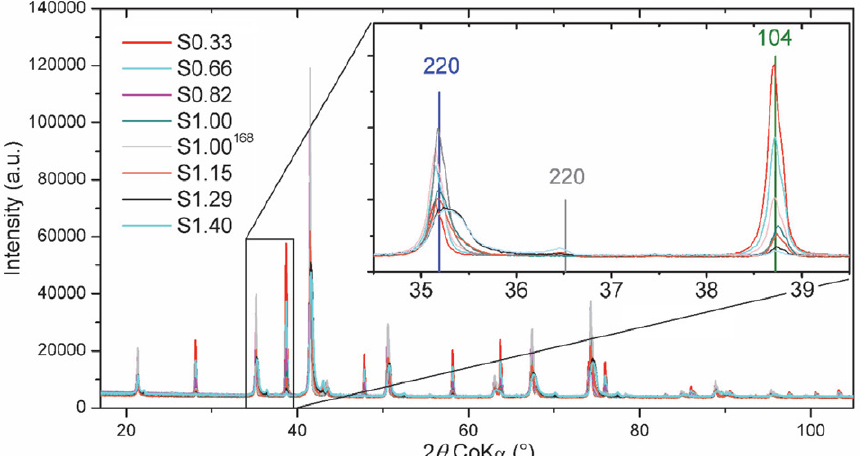
Figure 2. X-ray powder diffraction patterns for samples S0.33, S0.66, S0.82, S1.00, S1.00 168 , S1.15, S1.29 and S1.40. The cobalt ferrite (220), co- balt oxide (220) and hematite (104) reflections are shown in detail in the upper-right corner. The positions of these reflections are marked by blue, grey and green vertical lines, respectively.